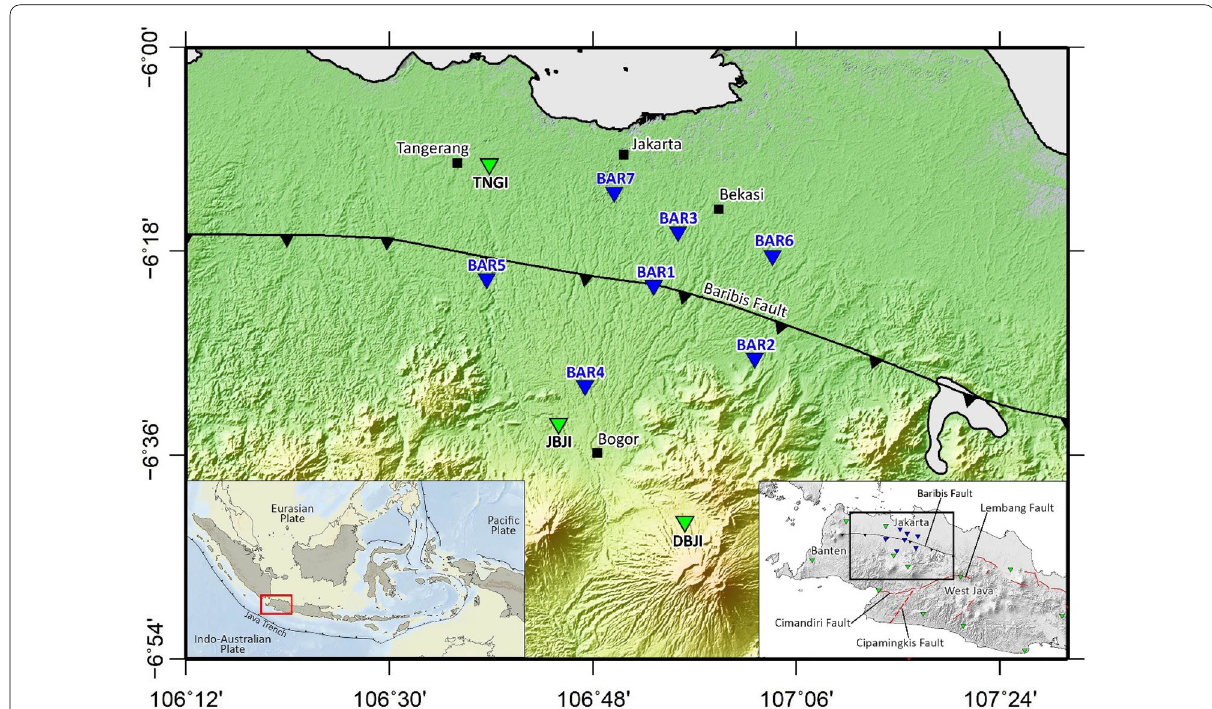
Fig. 1 Map of the study area. Blue and green inverted triangles are the borehole and BMKG seismic stations, respectively, used in this study; black line represents the Baribis Fault extracted from Simandjuntak and Barber (1996); left inset shows the location of the western part of West Java (red rectangle) with respect to the Indonesian region; right inset shows the location of the study area (black rectangle) with respect to the western part of Java. Red lines correspond to the other major crustal faults, including Cimandiri and Lembang Faults which were extracted from Irsyam et al. (2017, 2020) and the Cipamingkis Fault (Gunawan and Widiyantoro